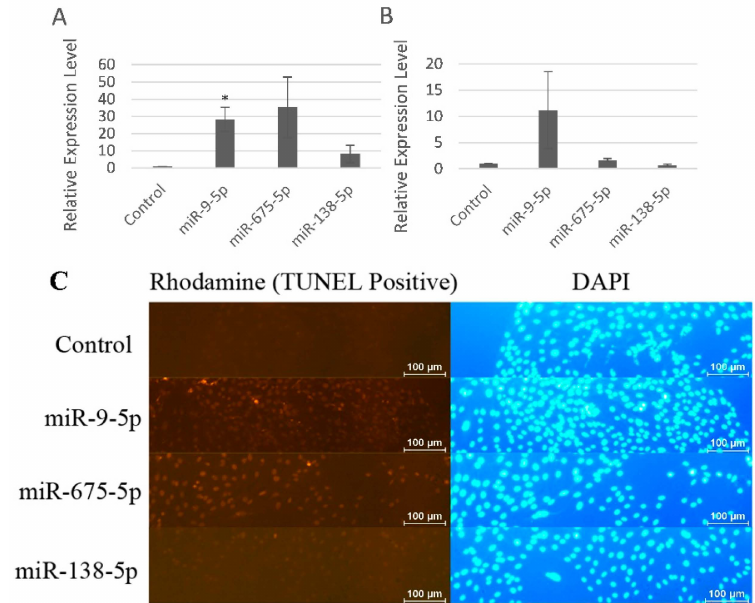
Figure 4. miR-9-5p and miR-675-5p induced MC3T3-E1 cell apoptosis more specifically than miR-138-5p. ( A ) Expression levels of FasL in MC3T3-E1 cells upon transfection of miR-9-5p, miR-675-5p, and miR-138-5p; ( B ) Expression levels of p53 in MC3T3-E1 cells upon transfection of miR-9-5p, miR-675-5p, and miR-138-5p, respectively; ( C ) TUNEL cell apoptosis assay of miR-9-5p, miR-675-5p, and miR-138-5p. * p < 0.05. n =